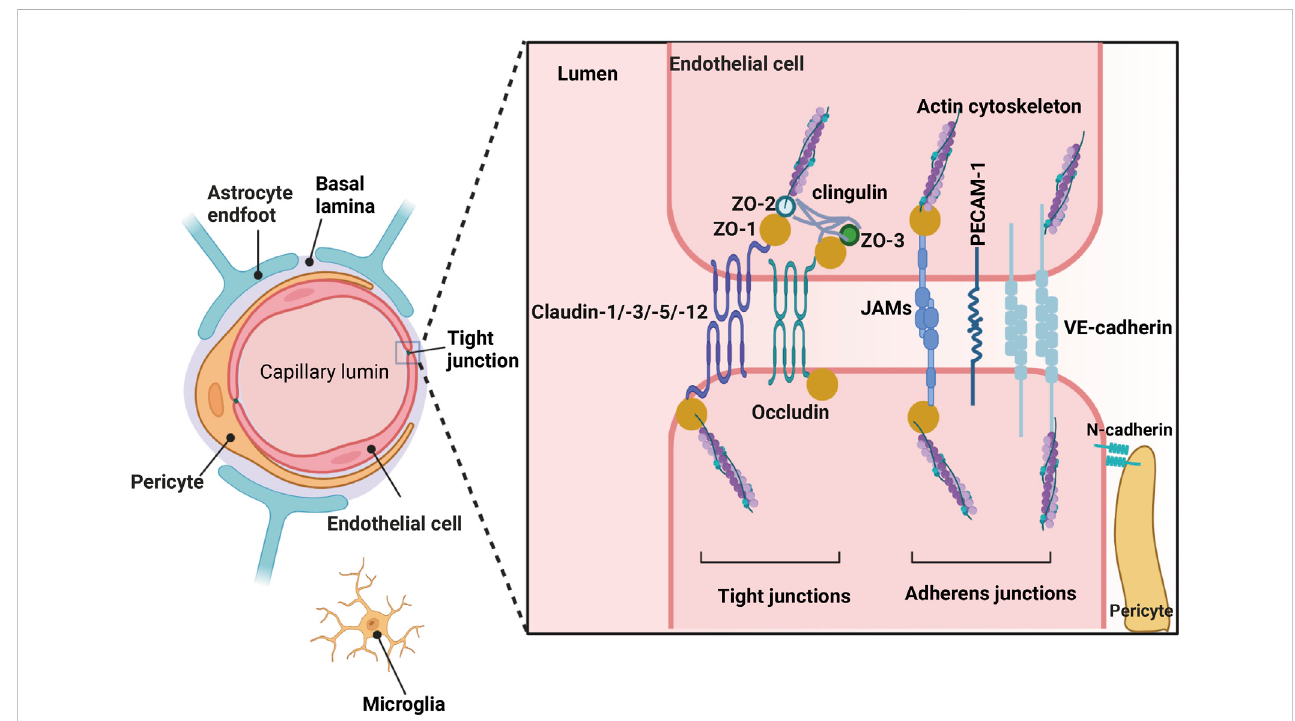
FIGURE 1 Structure of the blood-brain barrier (BBB) depicted graphically. Created with